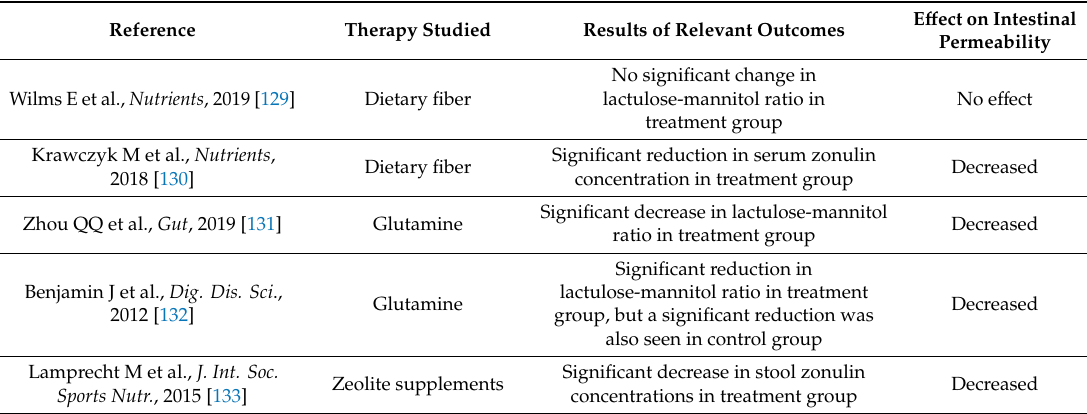
Table 2. Examples of randomised-controlled trials that study the e ff ect of dietary therapies on the intestinal barrier that have been published in the last ten